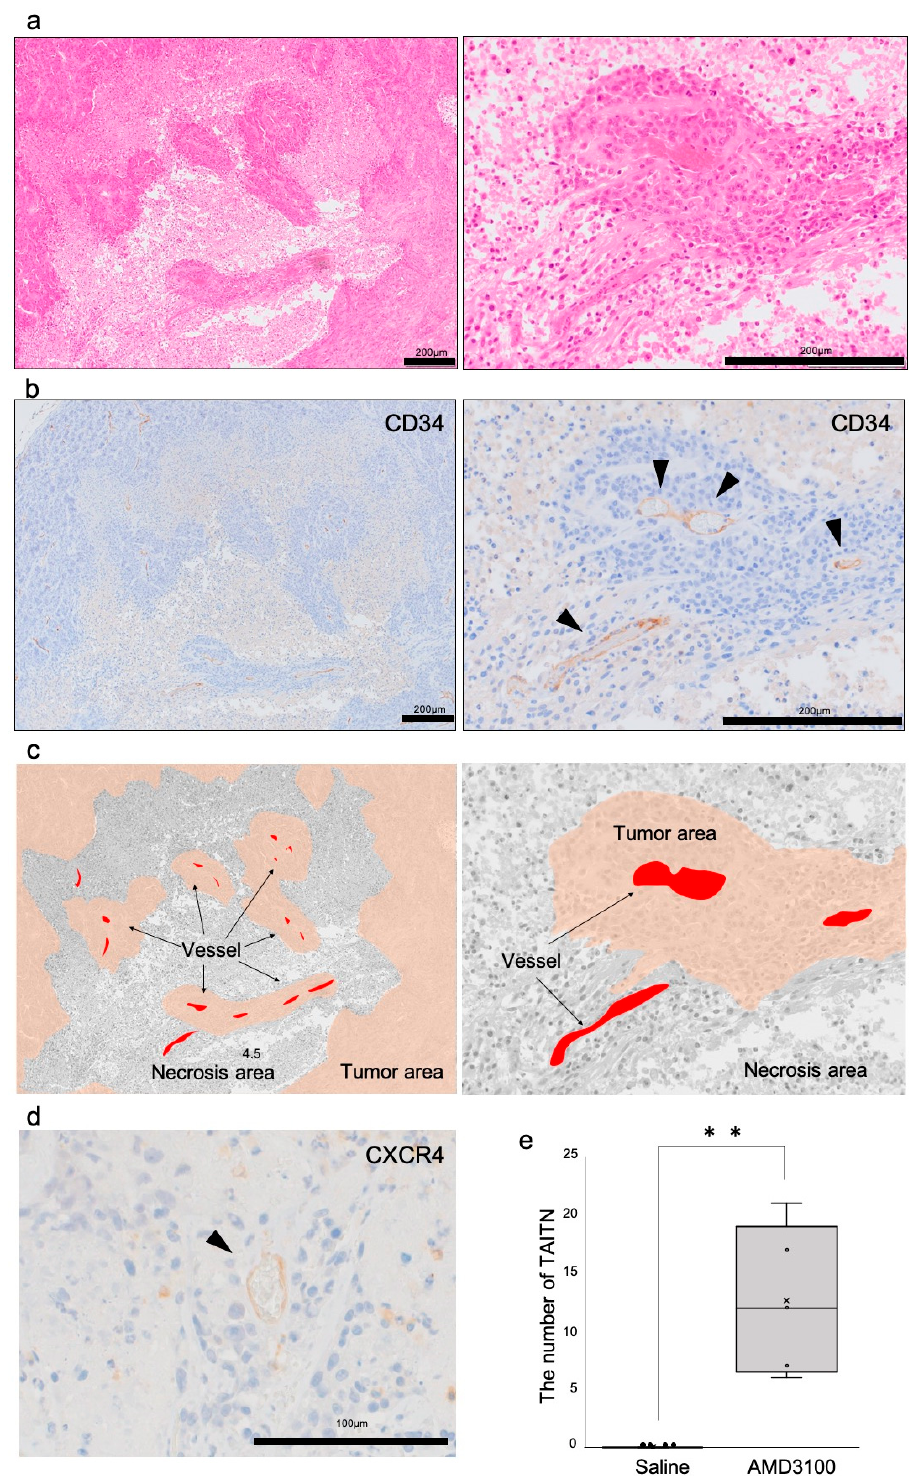
Figure 4. Pathological analysis of tumor angiogenic inhibition triggered necrosis (TAITN) induced by CXCR4 antagonism. ( a ) Representative HE staining of tumor necrotic area in an AMD3100-treated mouse. ( b ) Representative IHC for CD34 in the tumor necrotic area in an AMD3100-treated mouse. ( c ) Illustration of the structure of TAITN found in AMD3100-treated mice. Gray, necrotic area. Red, tumor vessels. Brown, tumor area. Islanded tumor areas are surrounded by necrotic area. The center of each tumor island is occupied by vessels. We defined this unique pathophysiological conception as TAITN. ( d ) IHC for CXCR4 in the TAITN. CXCR4-positive blood vessels were observed at the center of TAITN. ( e ) The number of vessel-tumor islands in the AMD3100 group and saline group. ** p = 0.0031, N = 5